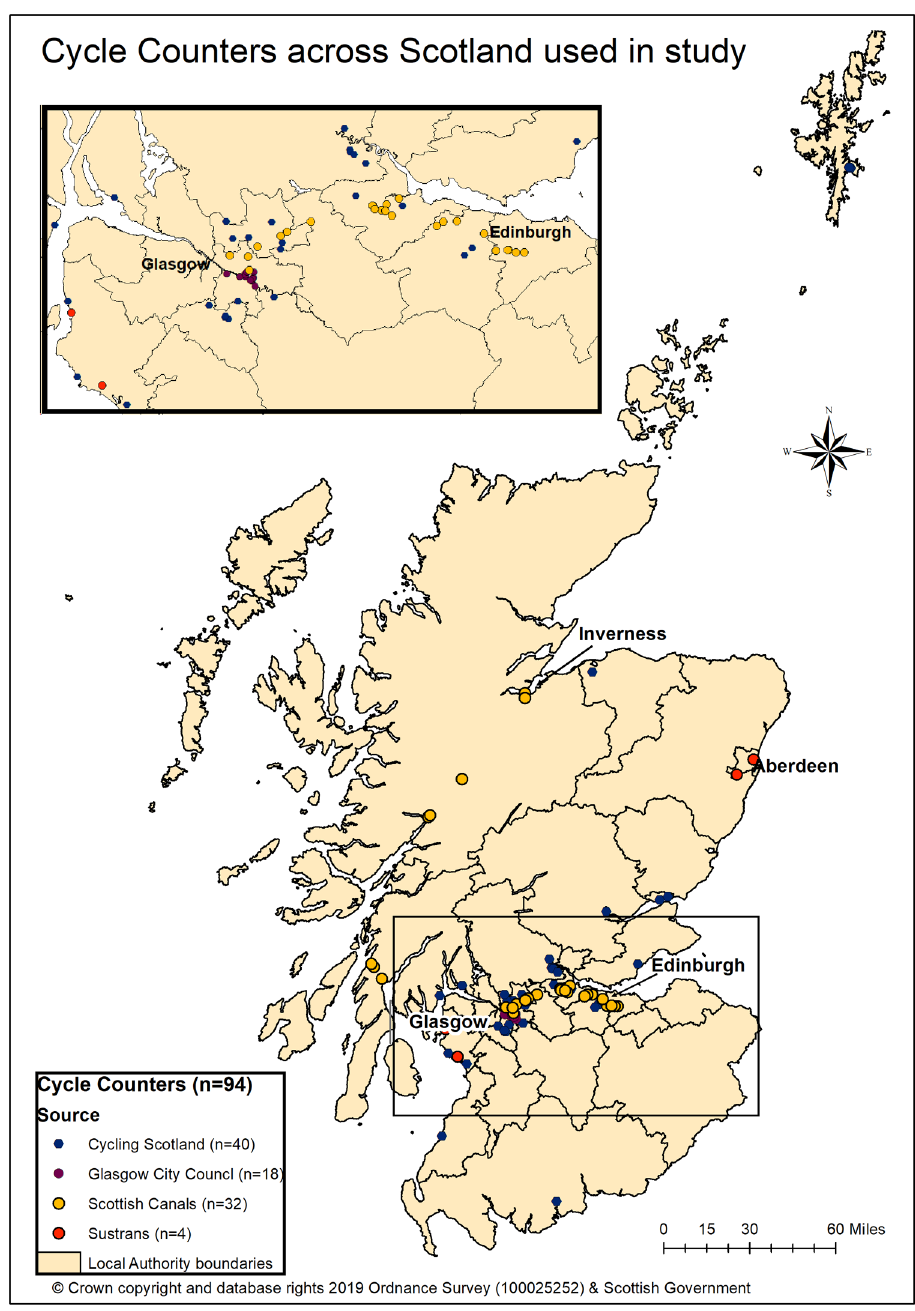
Figure 1: Map of cycle counters across Scotland used in study. Selected cities and local author- ity boundaries